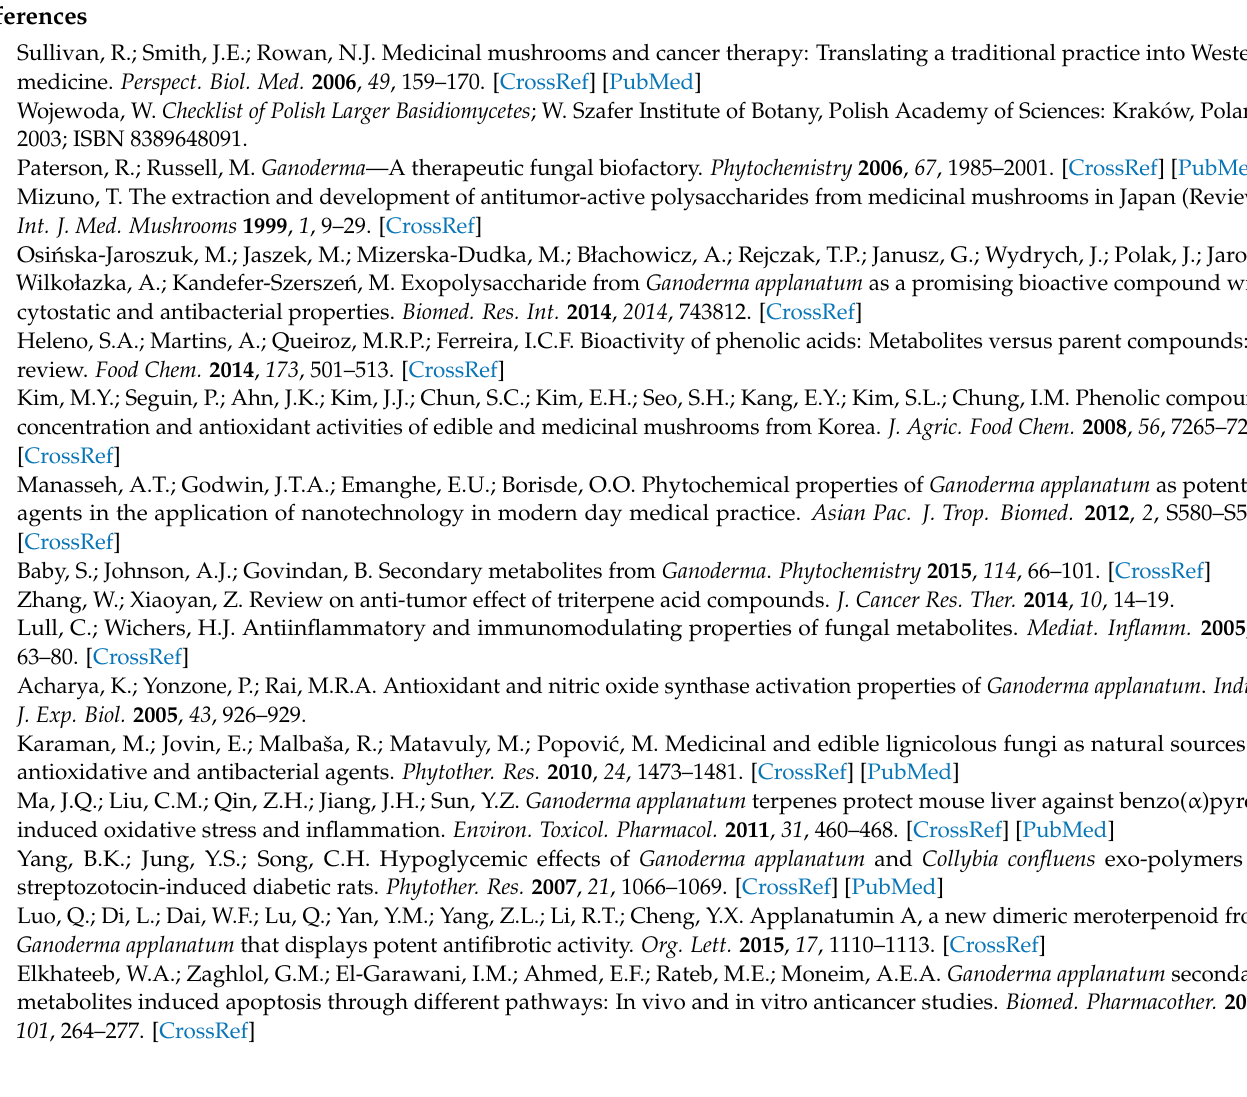
HaCaT; Table S3: Statistical differences for cytotoxic activity of Ganoderma applanatum extracts and ganoderic acid A; (5–100 µ g/mL) to gastrointestinal tract cell lines panel–Caco-2, HT29,